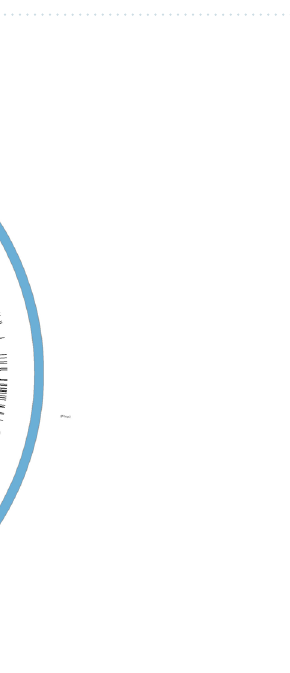
Figure 4. A scan of LOD profiles in a group of analogous traits. T13, T16 and T19 represents the height of 1st, 2nd and 3rd uromere, respectively.